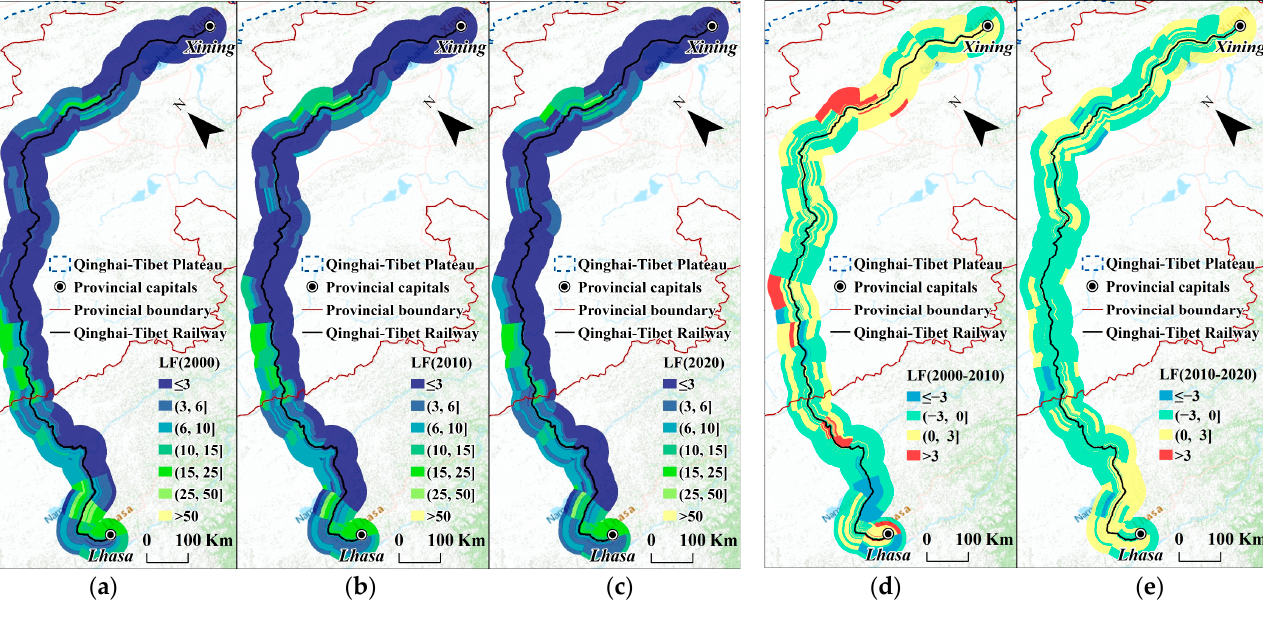
Figure 5. LF of different road sections and different buffers. ( a ) LF in 2000; ( b ) LF in 2010; ( c ) LF in 2020; ( d ) increase in LF from 2000 to 2010; ( e ) increase in LF from 2010 to 2020.